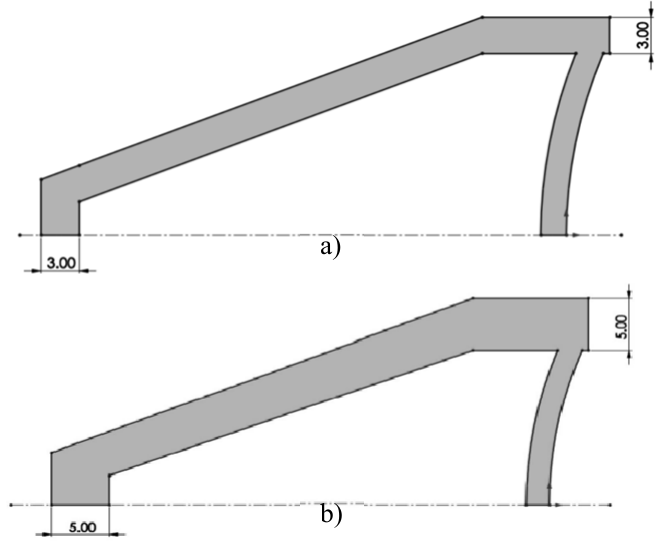
Figure 7. Different metal casing thicknesses used in numerical simulations (Solidworks)